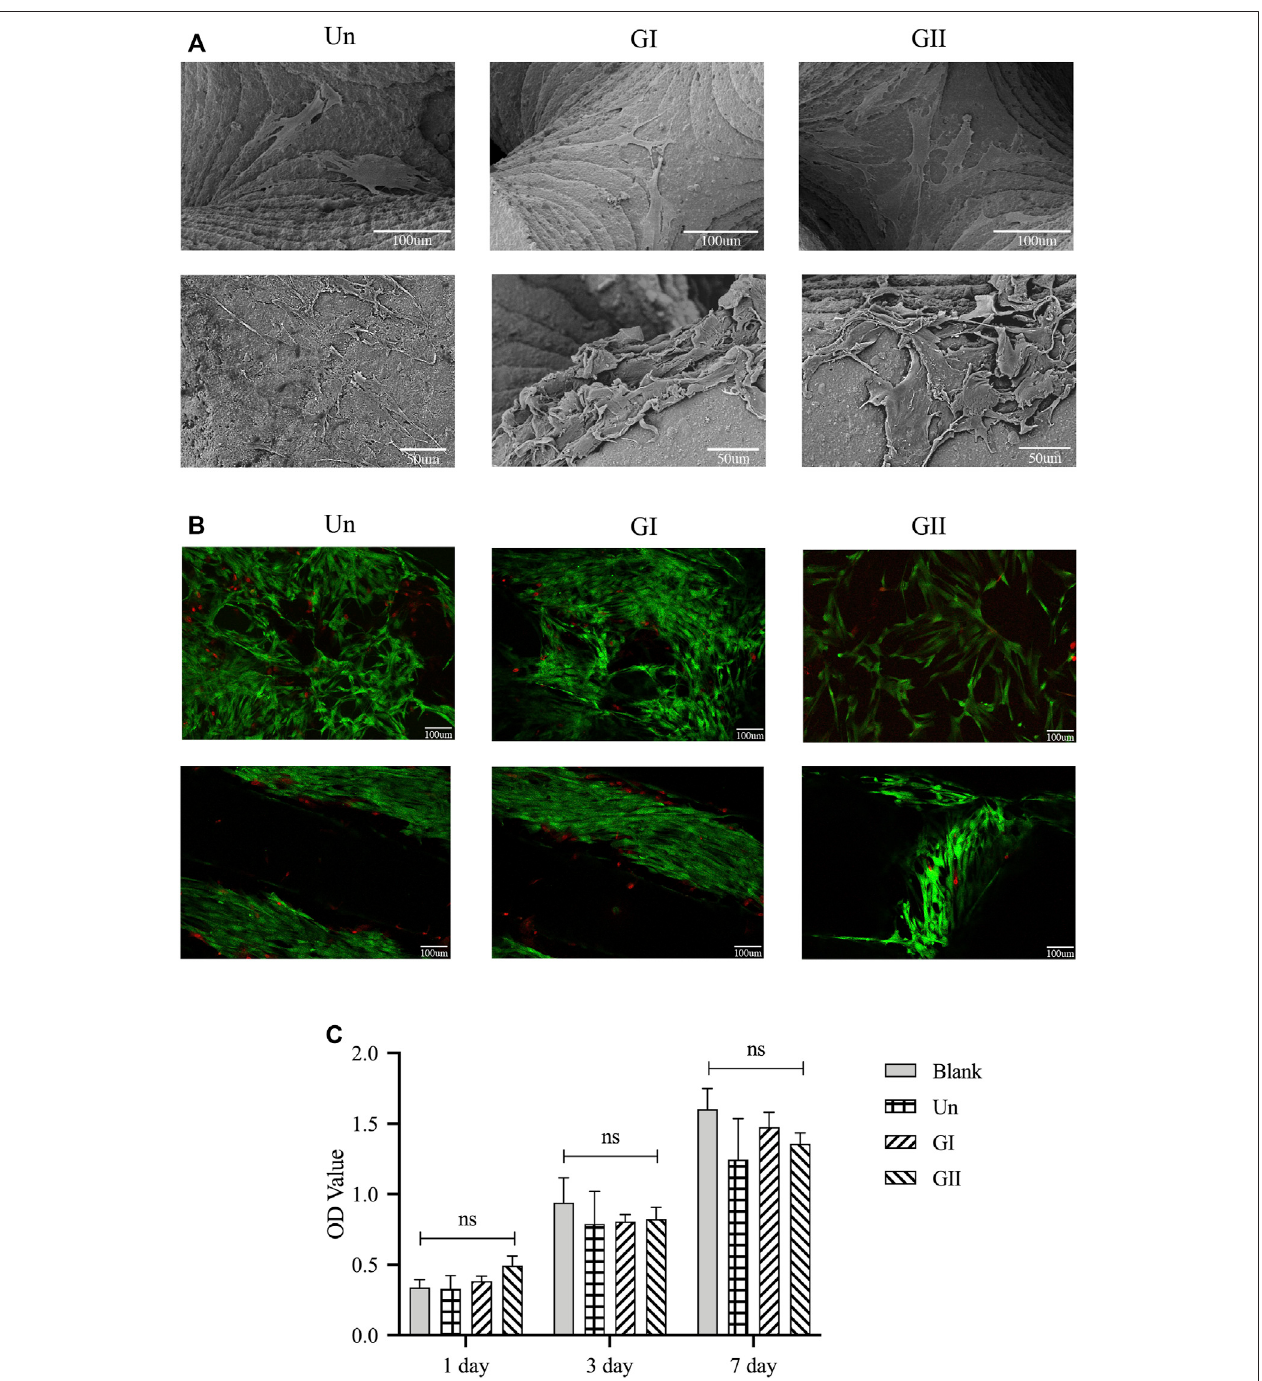
FIGURE5| Celladhesion,growth,morphologyandviabilityontheporousscaffolds. (A) SEMimagesofrBMMSCsmorphologyonscaffoldsafterbeingculturedfor 3 and 7 days; (B) Live/Dead staining of rBMMSCs on the scaffolds after 3 and 7 days of culture, green represents living cells, red represents dead cells. (C) rBMMSCs adhesion and proliferation on the